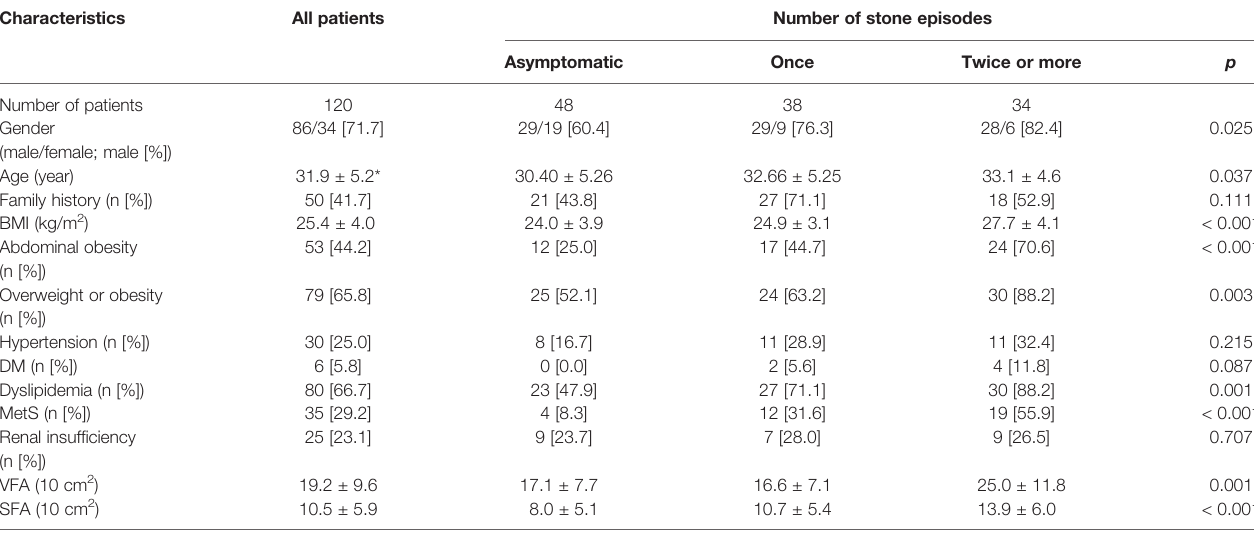
TABLE 1 | Demographic and metabolic characteristics of SFs with different stone episodes. Characteristics All